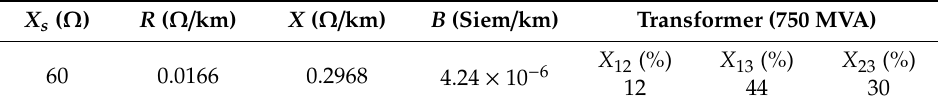
Table 1. Primary device parameters.